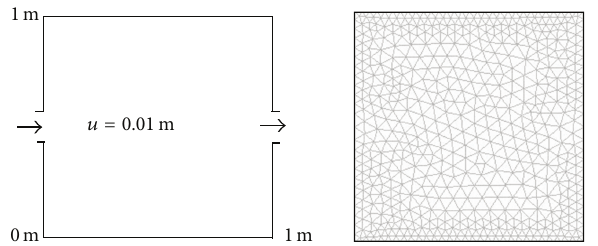
Figure 2: Two-dimensional single-phase free-flow model and Delaunay triangle subdivision.